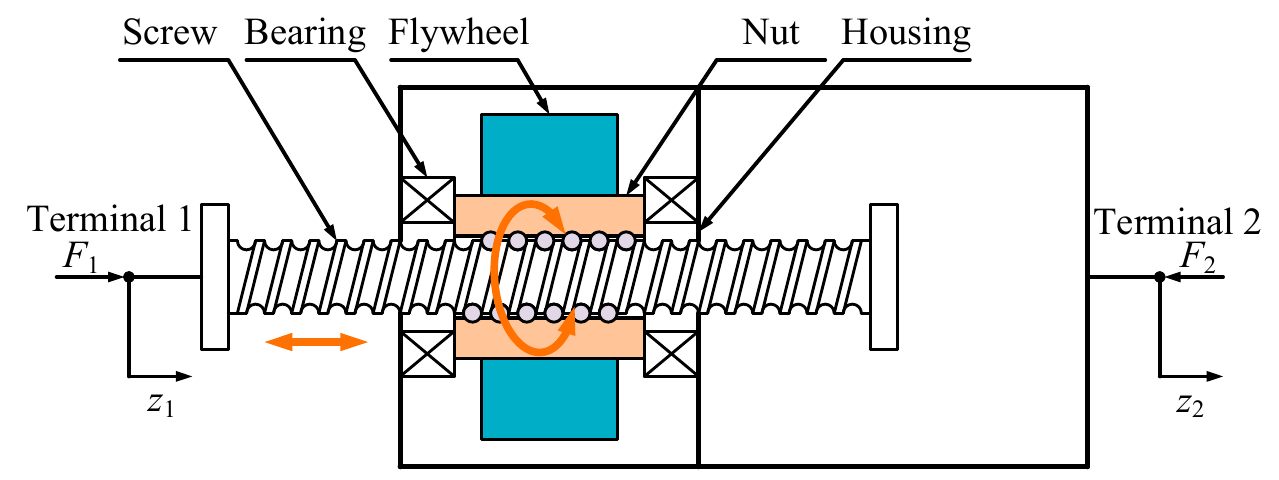
Figure 3. The mechanical diagram of the ball-screw inerter in [16–18].